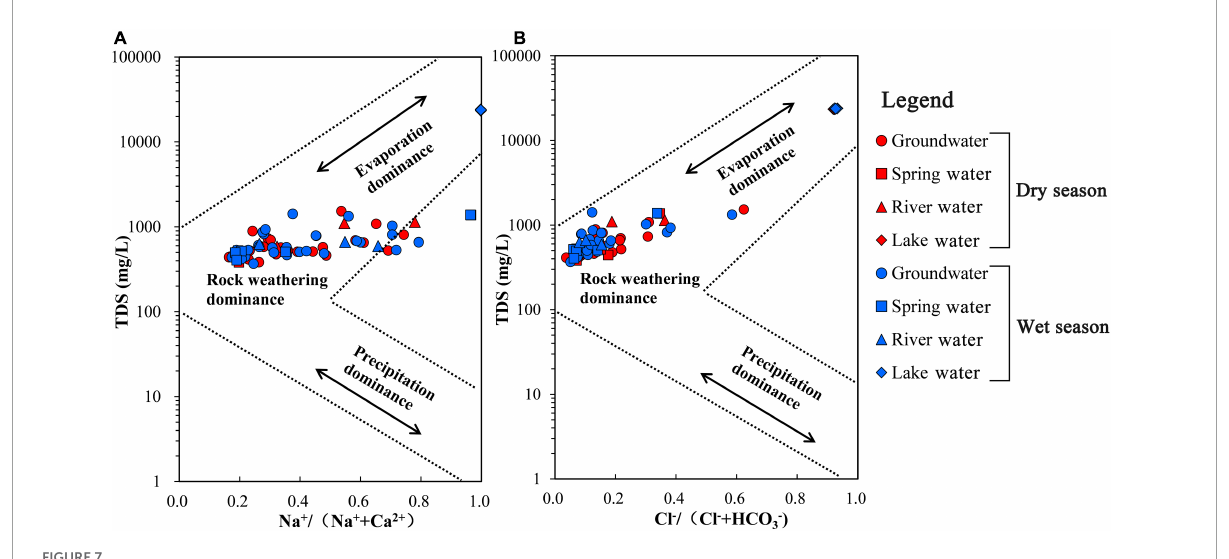
FIGURE7 Gibbs diagram (A,B) of hydrochemistry in the Daihai Lake